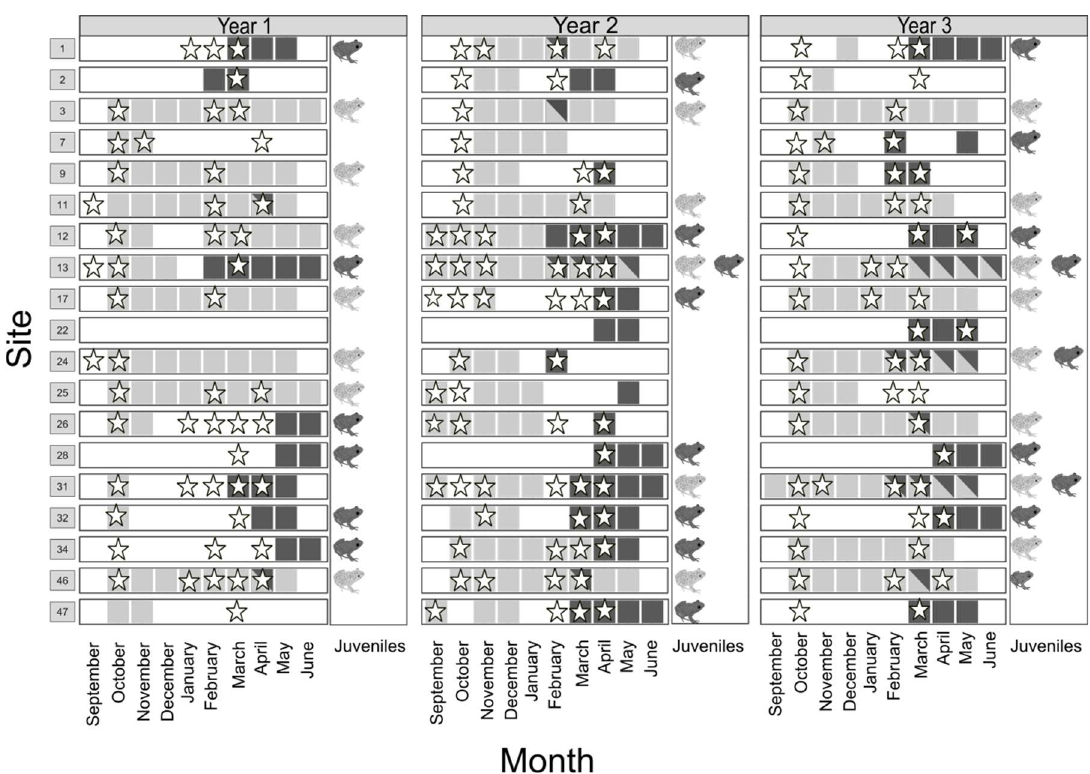
Figure 4: Summary of breeding strategy of the Parsley Frog in the 19 studied sites (vertical lines) in the three successive years: presence of egg masses (stars), presence of tadpoles (squares) and presence of metamorphs (frogs). Grey is indicative of autumn events and black is indicative of spring